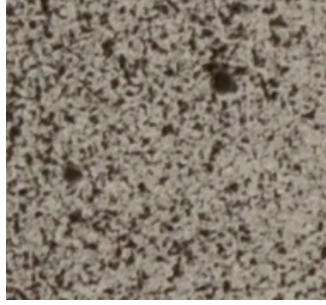
Figure 3. An example of a random speckle pattern.